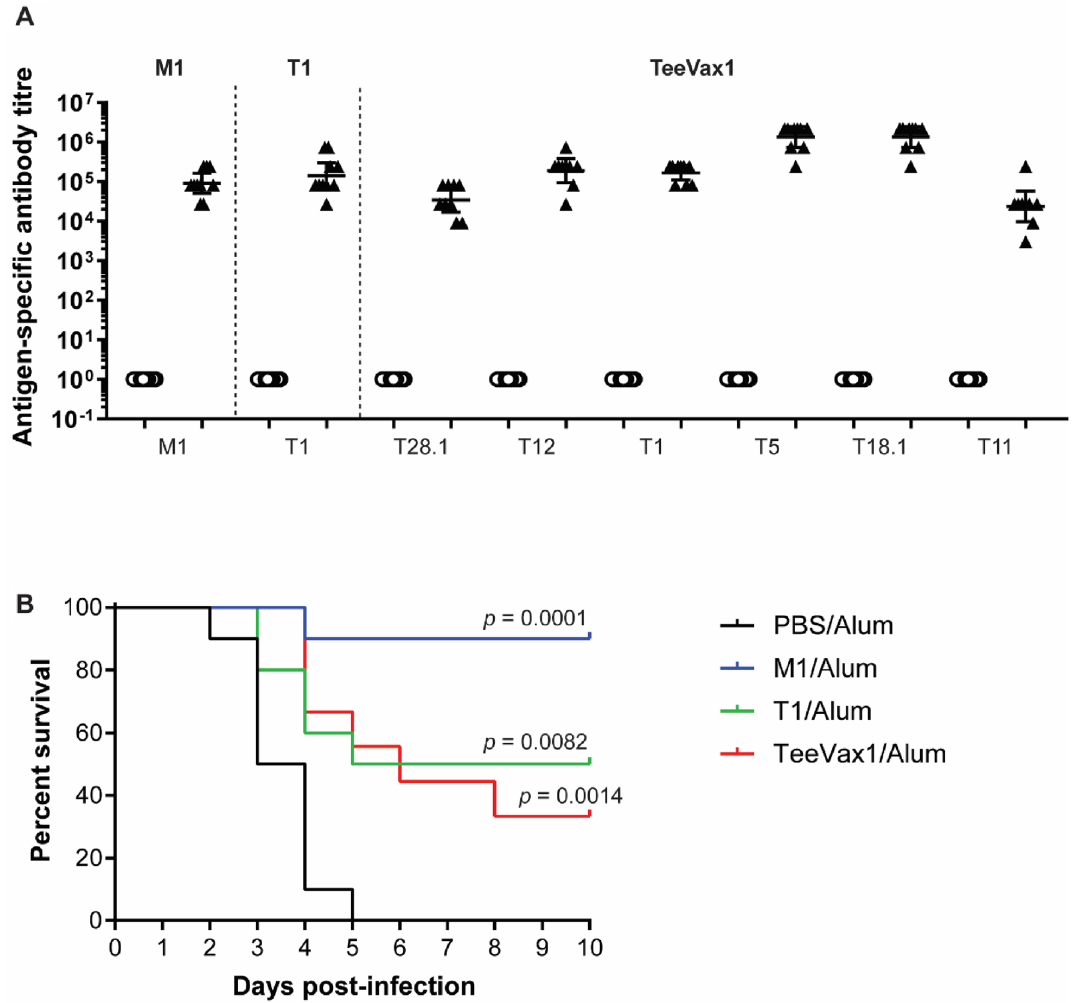
Figure 4. Mouse challenge model. Alb PLG1 mice were immunised i.m. with M1/alum (n = 10), T1/alum (n = 10), TeeVax1/alum (n = 9) or PBS/alum (n = 10). Two weeks after the final immunisation, all mice were challenged s.c. with GAS 5448 and monitored for 10 days. ( A ) Antibody titres from day 35 sera of immunised mice prior to challenge were measured by ELISA against cognate antigens. Circles = titre from PBS/alum- immunised mice, triangles = respective antigen-immunised mice. ( B ) Kaplan–Meier survival analysis of immunised mice challenged with GAS 5448. All groups were significantly protected from challenge compared to PBS control (log-rank Mantel-Cox